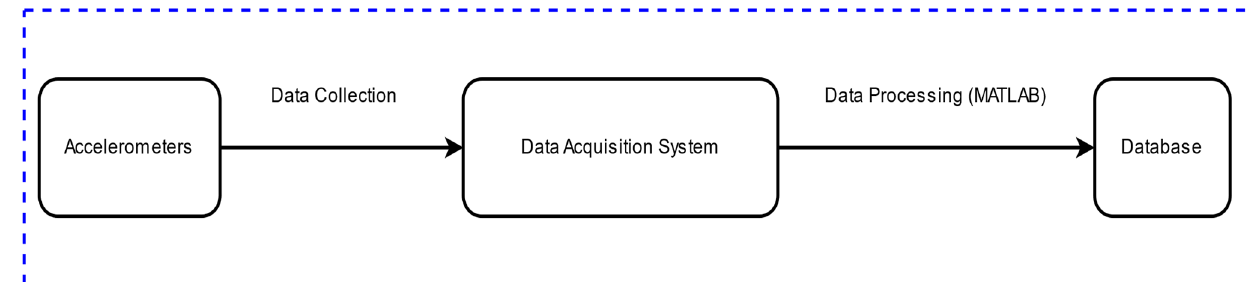
Figure 2. Vibration data collection process for CWRU ball bearing system.